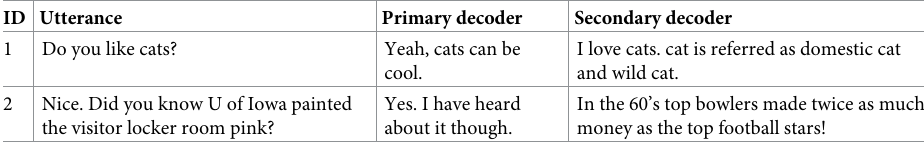
Table 10. Examples of the twin